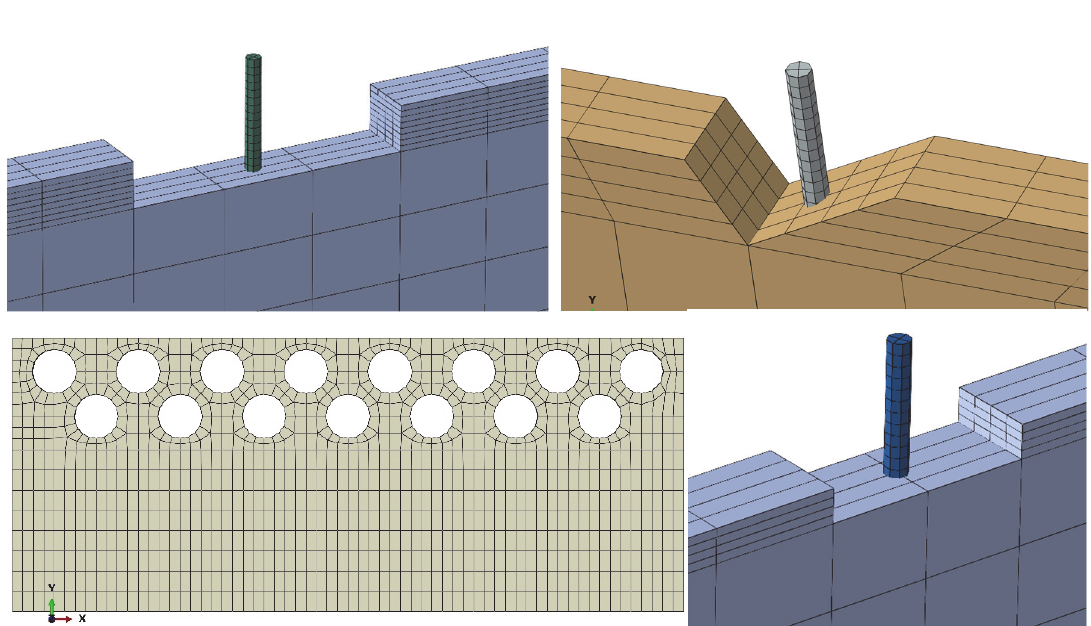
Figure 8: Modelling of R300 rectangular notch, R150 rectangular notch and triangular notch with embedded screw of 16 mm diameter and toothed metal plate